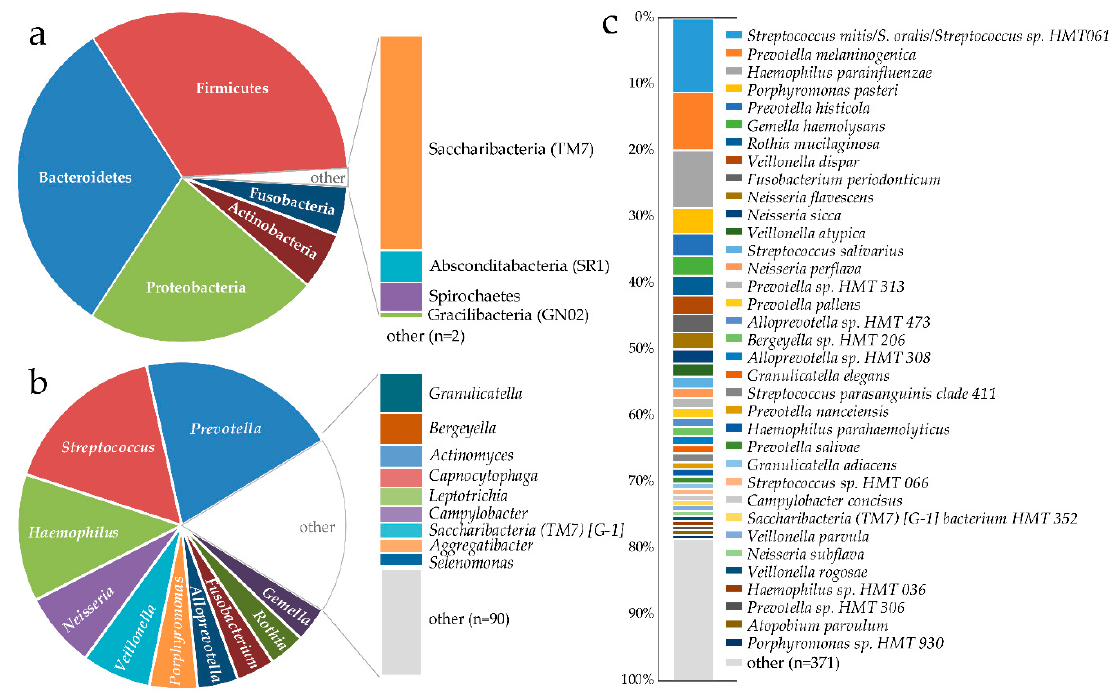
Figure 1. Pie and bar charts illustrating proportions of ( a ) identified phyla, ( b ) top identified genera, and ( c ) top eHOMD matched species.